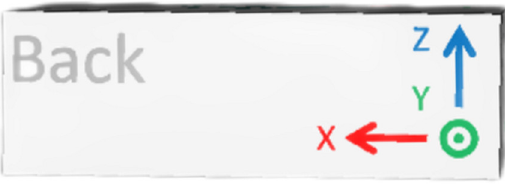
Figure 5. Local coordinate system.